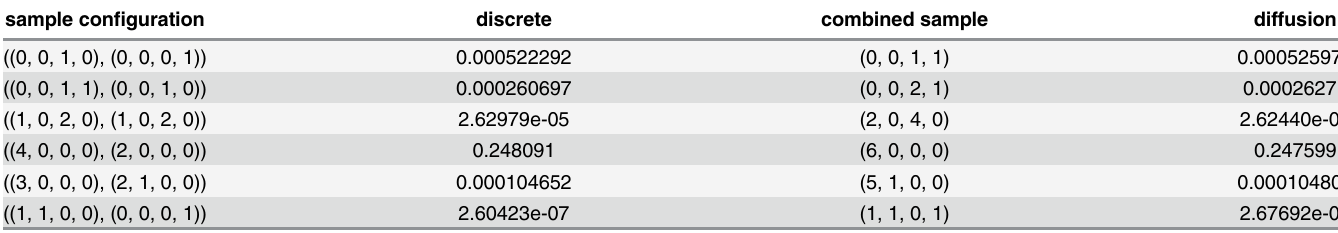
(cid:4) (cid:5) ; 4 5 5